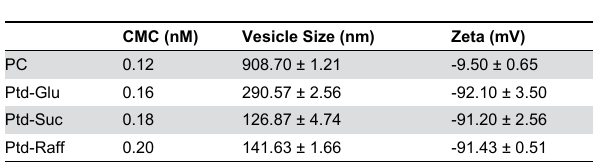
Table 1. Critical micelle concentration (CMC), liposome average size and zeta potential of PC, Ptd-Glu, Ptd-Suc and Ptd-Raff.